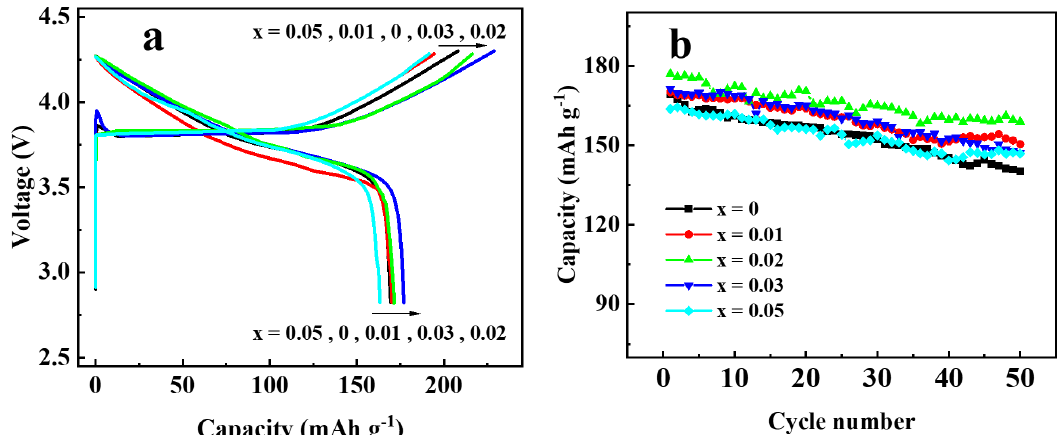
Figure 7. Charge–discharge performance of Li[Ni 0.6 Co 0.2 Mn 0.2 ] 1-x Ga x O 2 at 0.5C rate: ( a ) initial charge–discharge curves; ( b ) cycling performance.